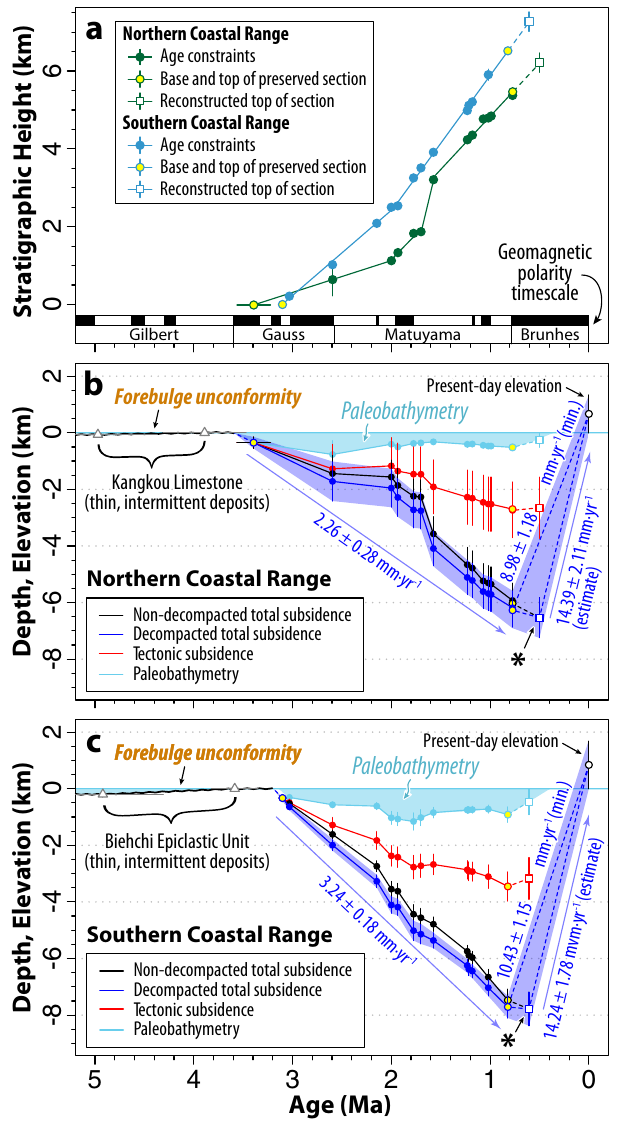
Fig. 3 Sediment-accumulation rates and subsidence-uplift histories of the Coastal Range. a Stratigraphic age models for the Coastal Range. b , c Geohistory curves of the northern and southern Coastal Range. Symbols and color- fi ll style follow Fig. 3a. Asterisk in each curve is the reconstructed depth using youngest sediment eroded from top of section. Error bars represent one standard error of the mean. See details of data and calculation results in Supplementary Data 4.